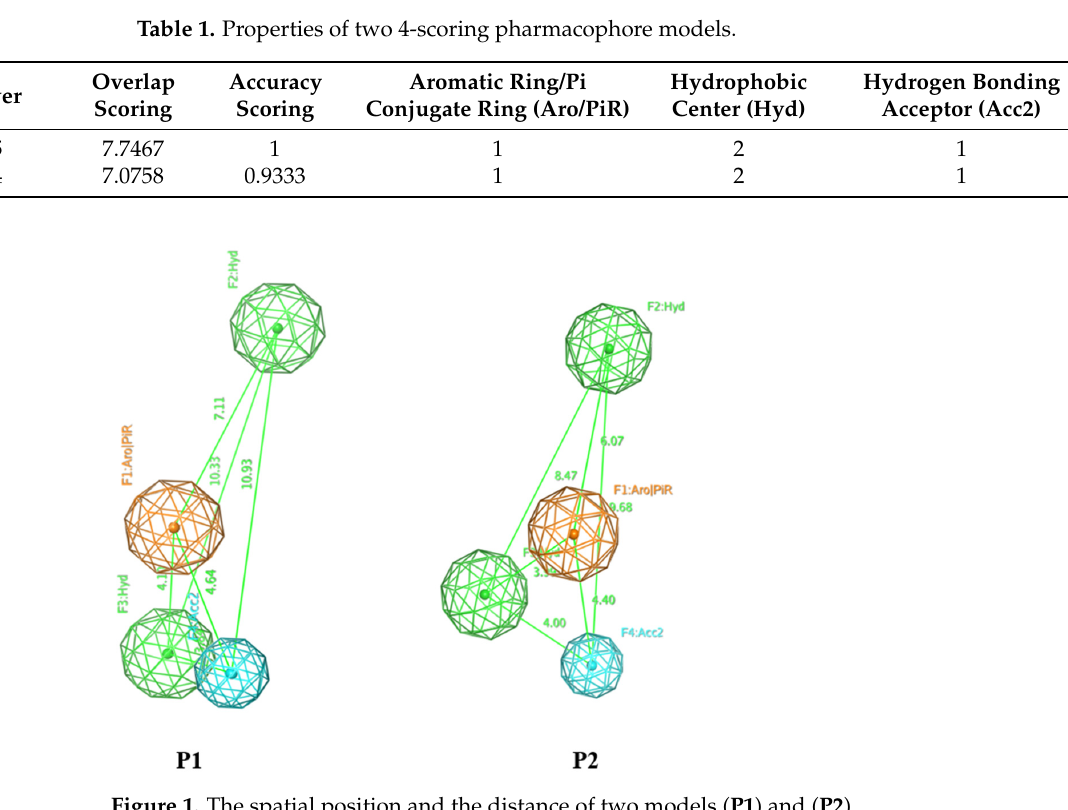
Figure 1. The spatial position and the distance of two models ( P1 ) and ( P2 ). Table 2. Evaluation results of pharmacophore models P1 and P2 by decoy set. Model